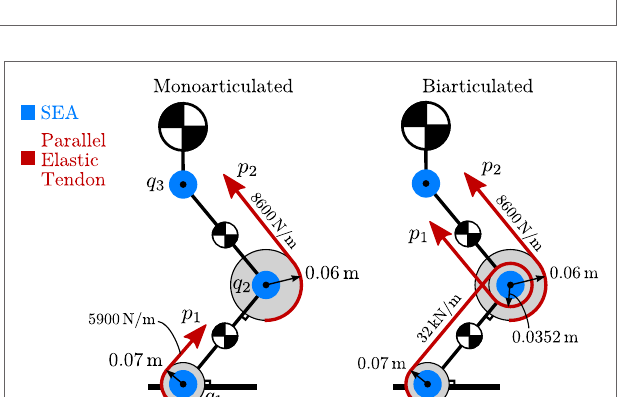
FIGURE 5 | Time evolution of the six evolutions shown in Figure 4 .